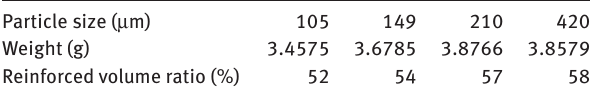
Table 3: Weight of the SiO forming 50 mm height.